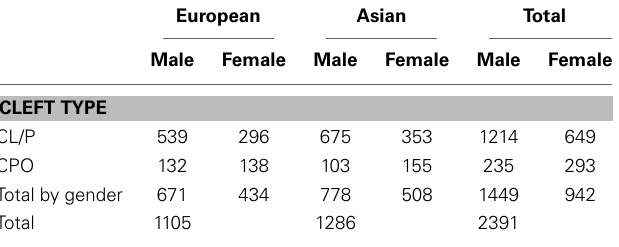
Table 5 | Case-parent families by cleft type, gender and ancestry.